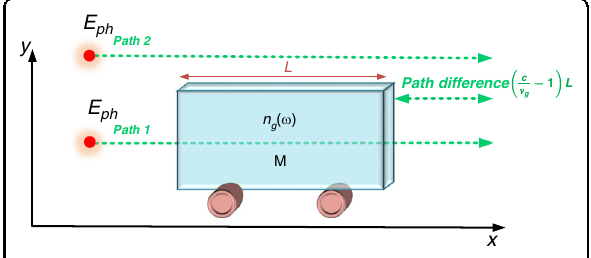
Fig. 2 Schematic of Balazs gedanken experiment inspired by 48,49 . The photon can either take path 1 inside the slab of mass M , length L and group index n g ( ω ) or follow path 2 in free space. The slab is supposed to move freely, without friction in the x direction